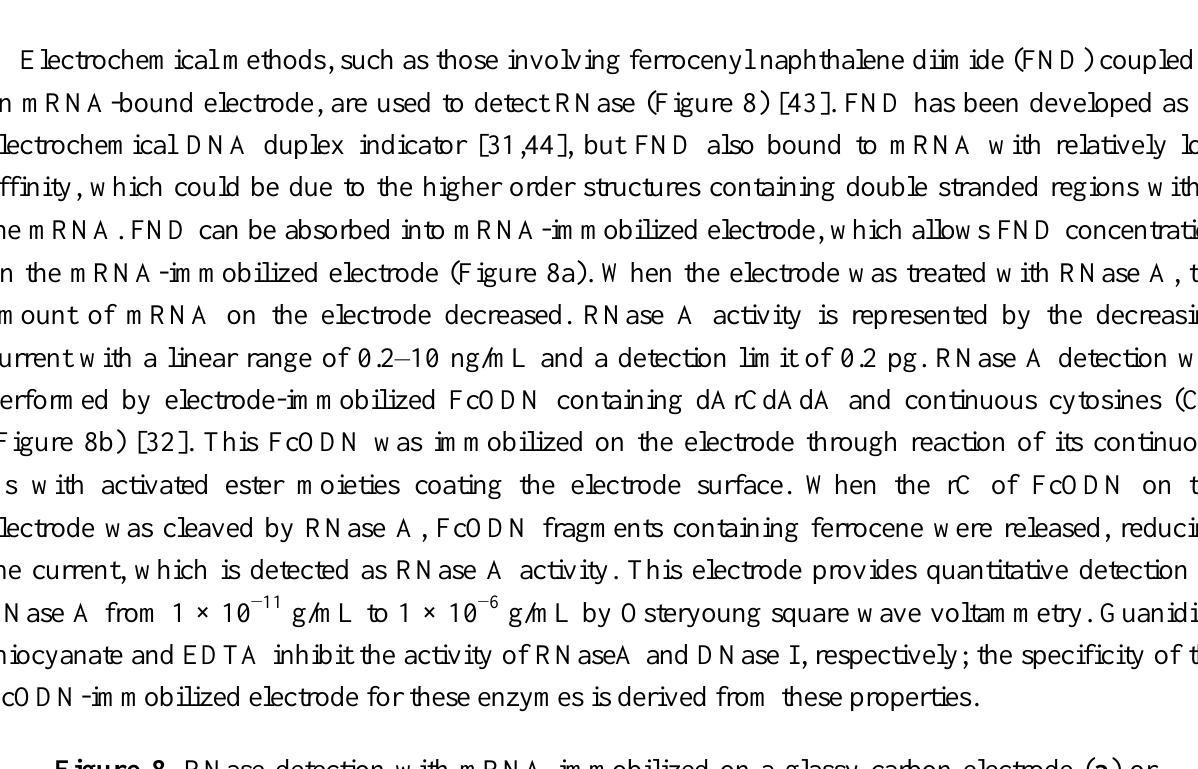
Figure 8. RNase detection with mRNA immobilized on a glassy carbon electrode ( a ) or ferrocene oligonucleotide with a ribonucleoside unit immobilized via continuous cytosine and the activated ester electrode ( b ). Current intensities decrease with RNase A